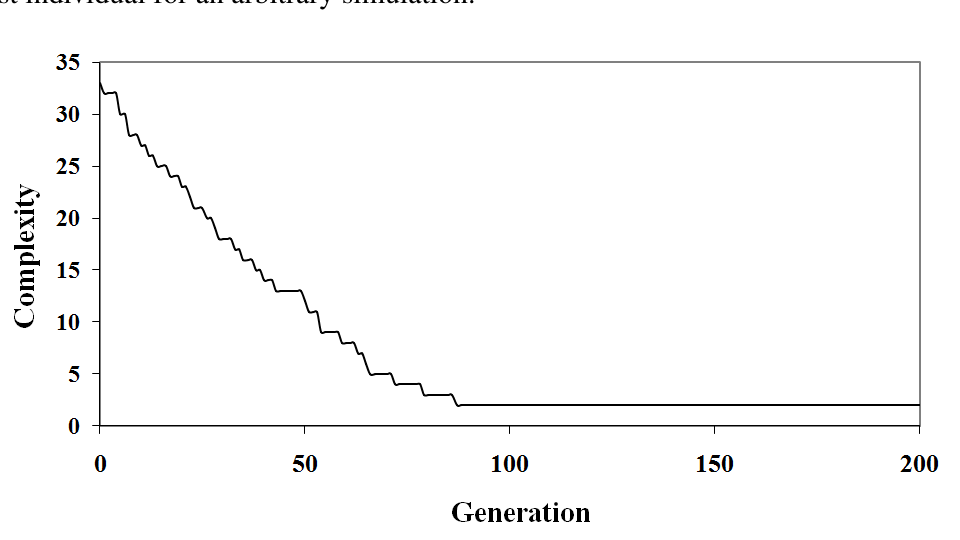
Figure 2. Algorithm Sample Run: The complexity as a function of algorithm iteration of the best individual for an arbitrary simulation.